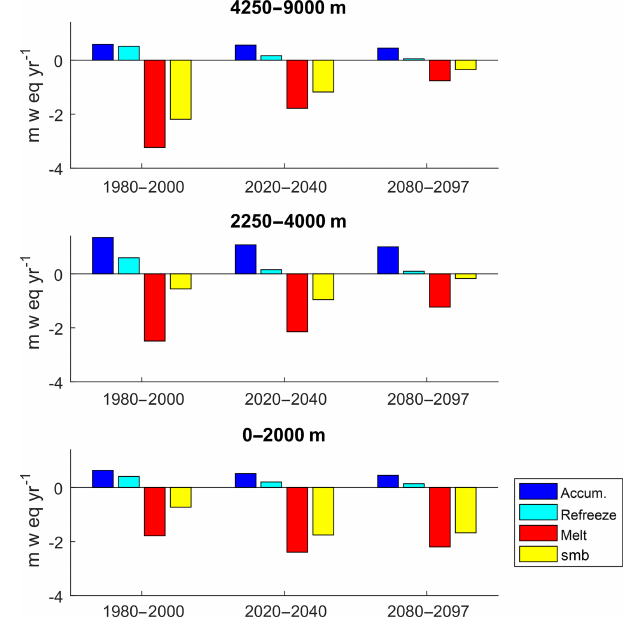
Figure 13. Global mass balance components for three elevation ranges. The historical period is calculated using the WFDEI data and the future period is the multi-model means of all GCMs. The bars show the averages over the time periods for accumulation, re- freezing, melt, and mass balance